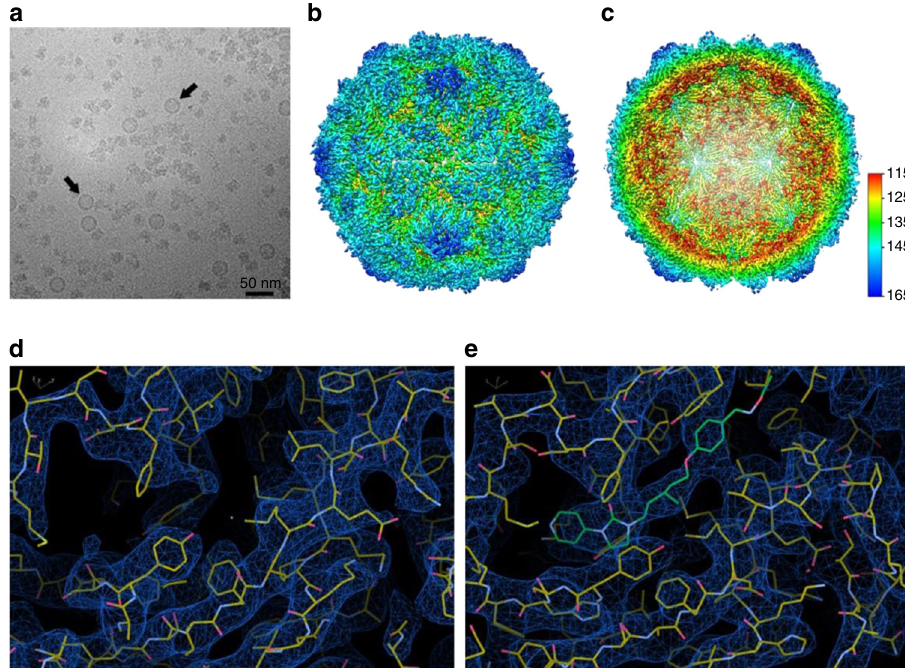
Fig. 3 Structure determination of PV3 sVLPs. a Cryo-EM image of PV3 SktSC8 VLPs in vitreous ice. Examples of some VLPs are highlighted with black arrows . Scale bar, 50 nm. b 3D reconstruction of PV3 SktSC8 sVLP at 3.6 Å resolution, viewed along the two-fold axis. The surface is colored by radius from the center of the VLP from blue through green to red from the highest to the lowest radius. c A central slice through the VLP to show the empty internal surface viewed along the two-fold axis and colored as in b . d Cryo-EM density map at 3.6 Å resolution of PV3 SktSC8 sVLP looking at the VP1 protein pocket. VP1 is shown as sticks with carbon atoms colored yellow , nitrogen atoms in blue and oxygen in red . e Cryo-EM density map at 4.1 Å resolution of the PV3 SktSC8 sVLP with GPP3 pocket factor compound bound to the VP1 protein pocket. VP1 is shown as sticks and colored as in d . The GPP3 molecule is colored in green . Cryo-EM density maps are contoured at 1.0